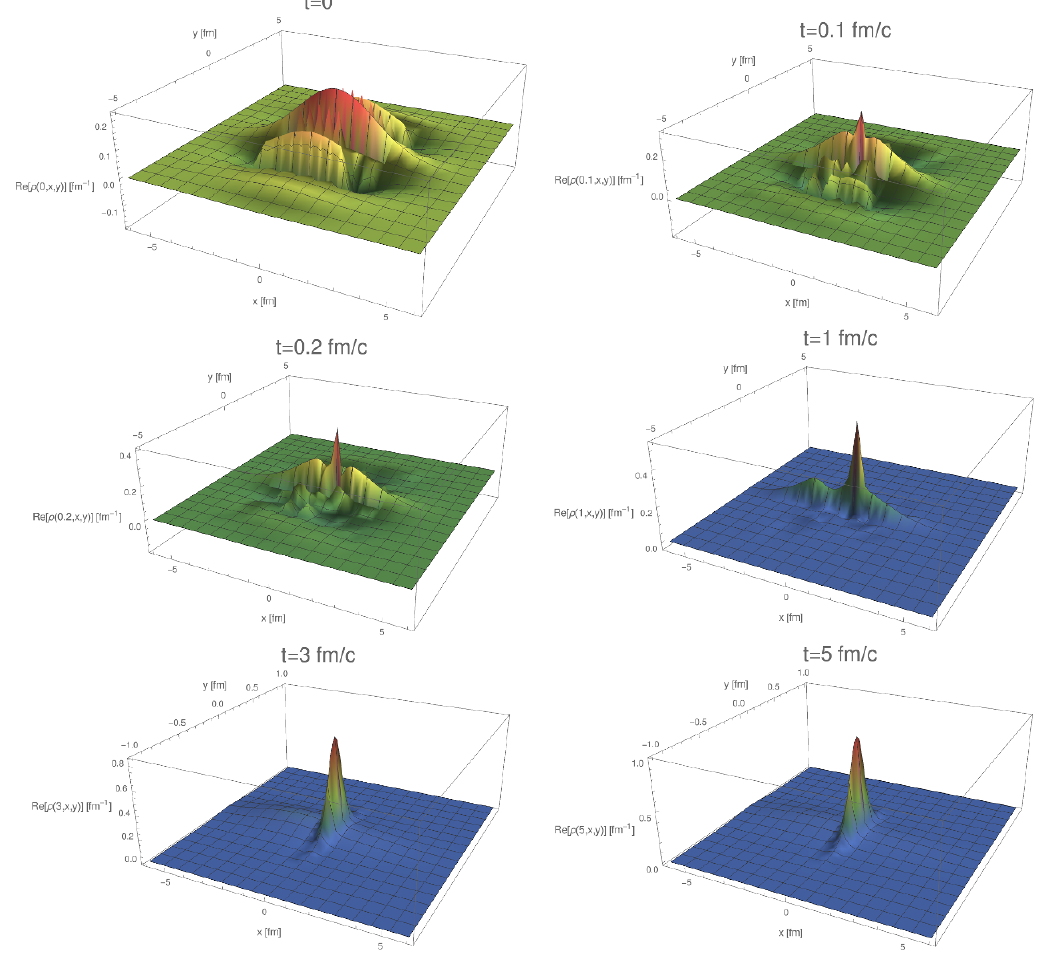
Figure 7 . Time evolution of the real part of the density matrix for the thermal scattering state de(cid:12)ned before, propagating through a bath with l env = 0 : 25 fm. Top: the medium disturbs the system at the very early times. Centre: quantum decoherence appears as a suppression of the o(cid:11)-diagonal elements of the density matrix. Bottom: the state is squeezed around y = 0 . Notice the di(cid:11)erent scale in the y